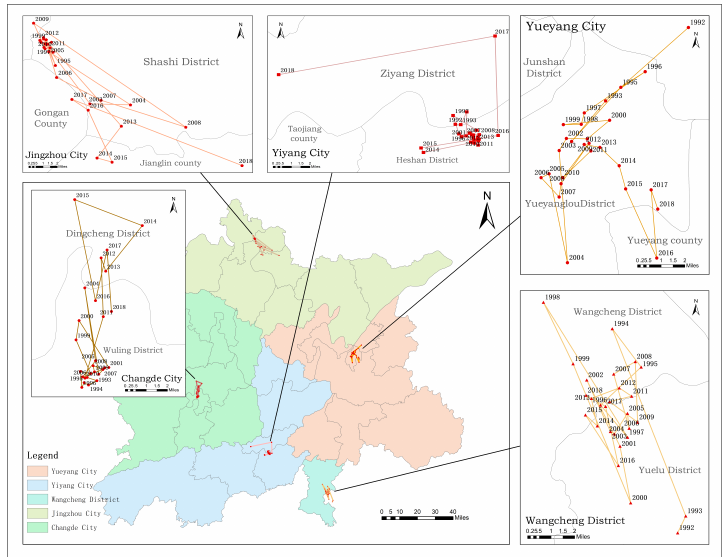
Figure 13. Weighted gravity center offset map of four cities and one